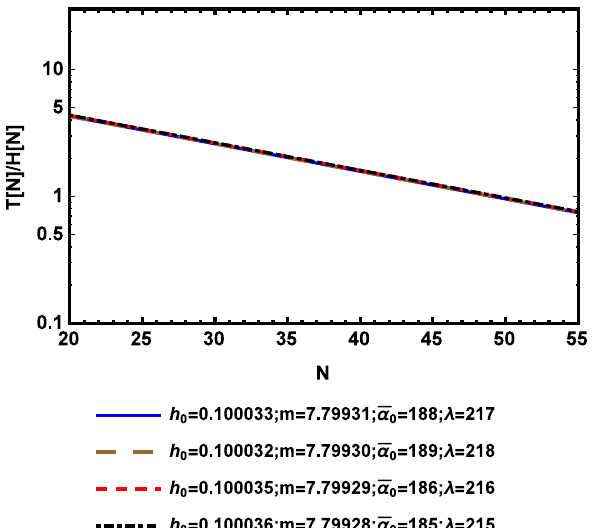
Fig. 6 The ratio of the temperature to the Hubble parameter during the inflationary evolution of the non-comoving model in the strong regime with power-law scale factors versus the number of e-folds for different values of the parameters of the model